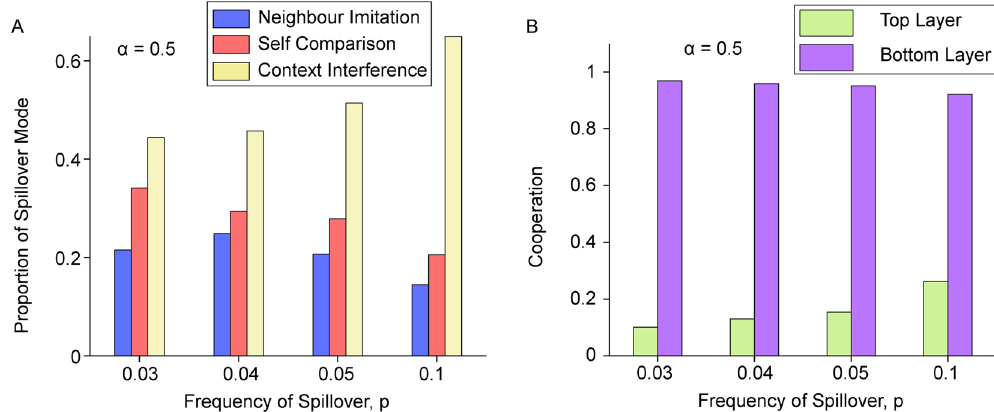
Figure 5. Coevolution of spillover modes and cooperation. Figure 5 shows the proportion of each spillover mode, for low values of p , when spillover modes coevolve with strategy in the presence of mutation. Self comparison (red) is second place in ( A ) despite having the most individuals who cooperate on both layers. Context interference (yellow) has the largest proportion due to having the most individuals playing the payoff maximizing combination of C on the bottom layer and D on the top layer. Neighbour imitation (blue) accounts for the least proportion of the population. ( B ) shows that cooperation in the top layer increases with p but at the expense of cooperation in the bottom layer. Parameters: n = 400, m = 4, c = 0.35, β = 0.2, b = 1. Mutation rate μ = 10 − 4 , 7.2 × 10 9 total time steps, combined from at most 7 runs for both ( A and B